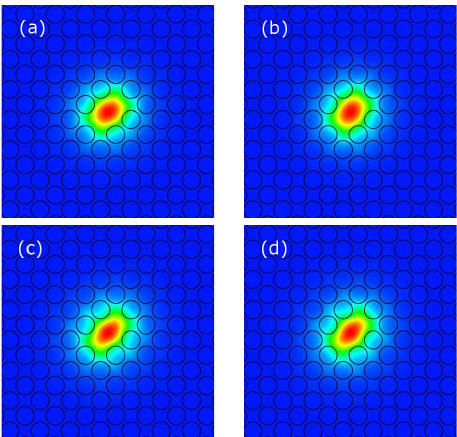
Figure 4. Magnetic field distributions of ( a ) H x and ( b ) H y components for the fundamental mode, and ( c ) H x and ( d ) H y components for the 1st-higher-order mode with d c / Λ = 0.6 and ∆ D / Λ =